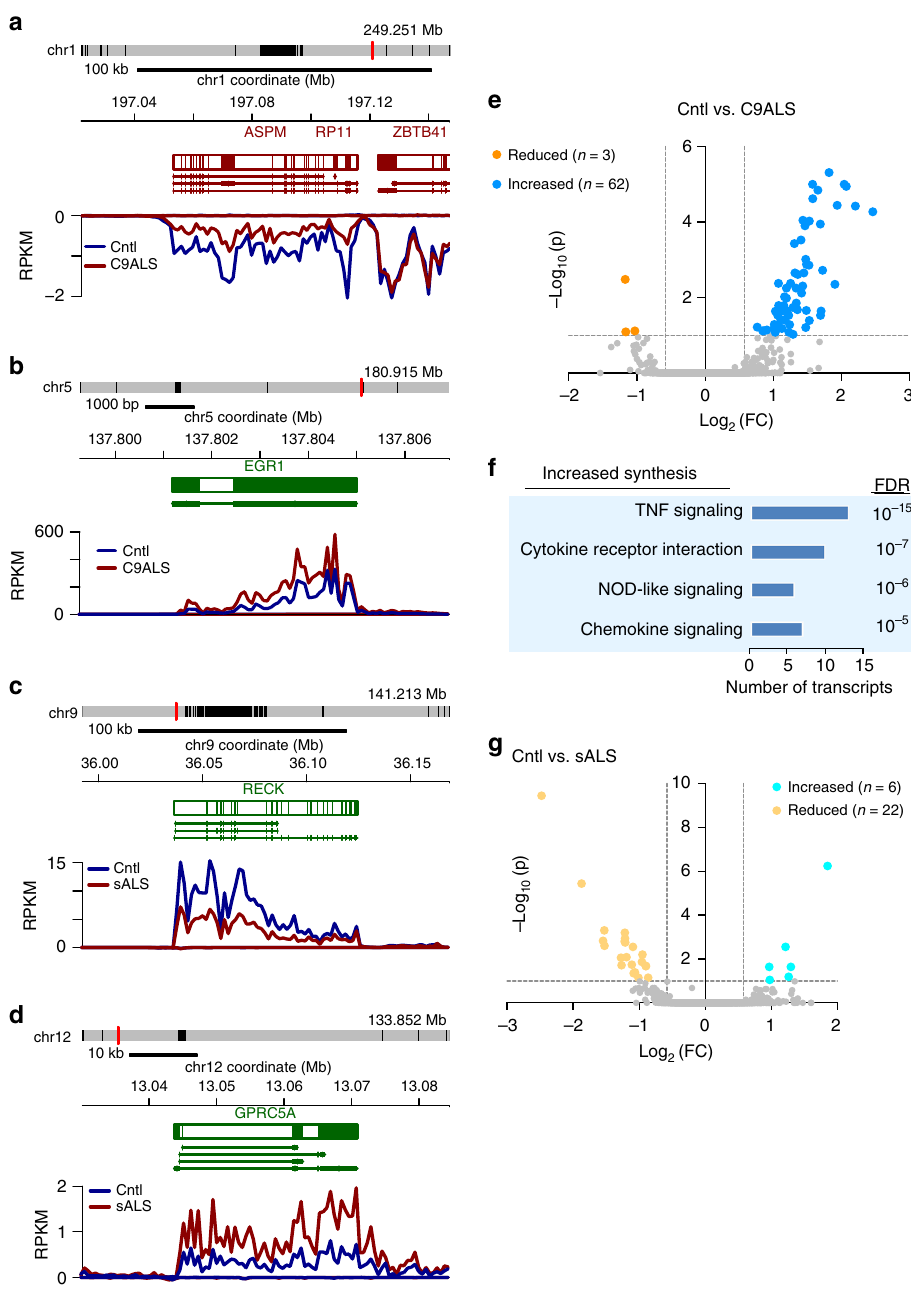
Fig. 2 Abnormal RNA synthesis in ALS fi broblasts. Examples of RNA transcripts showing reduced ( a ) and increased ( b ) synthesis in C9ALS fi broblasts. The traces represent RNA abundance 0.5 h following Bru labeling. Representative schematics of RNA transcripts exhibiting reduced ( c ) and increased ( d ) synthesis in sALS fi broblasts. e Volcano plot for 65 transcripts showing signi fi cant changes in synthesis in C9ALS fi broblasts, in comparison to control (Cntl) cells. f Gene ontology was performed for transcripts displaying reduced synthesis in C9ALS fi broblasts. FDR false discovery rate. g Volcano plot for 28 transcripts exhibiting signi fi cant changes in synthesis in sALS fi broblasts, compared to control cells. Dotted lines in e and g depict an adjusted p value of 1 and fold change (FC) of 1.5. Cell lines used for these experiments are listed in Supplementary Table